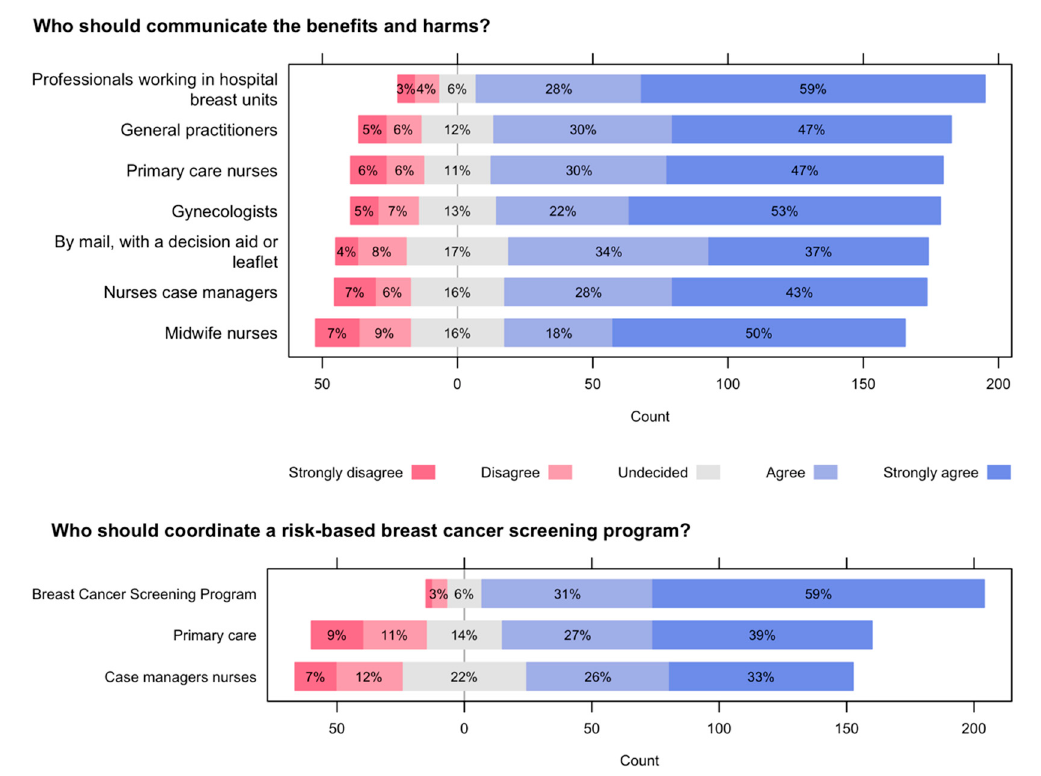
Figure 8. Who should communicate the benefits and harms of breast cancer screening, before women decide to participate? ( top ) and Who should coordinate a risk-based breast cancer screening program for the initial invitation and follow-up? ( bottom ).